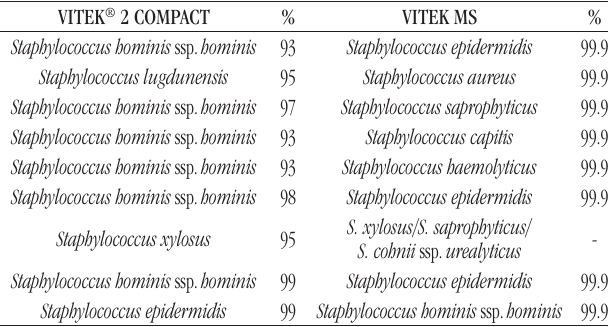
taBLE − Disagreeing results in CNS identification by VITEK ® 2 Compact and VITEK MS (bioMérieux,